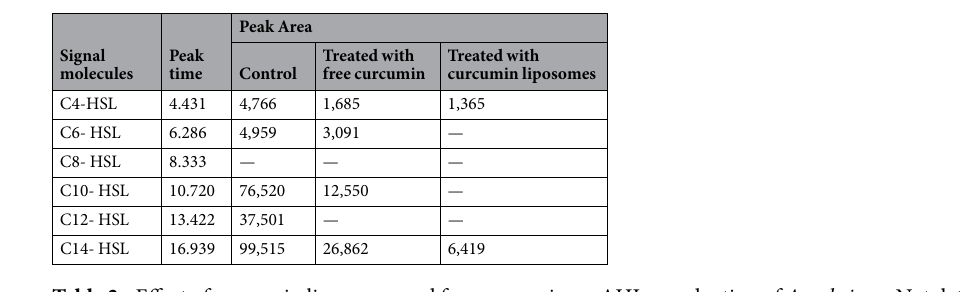
Table 2. Effect of curcumin liposomes and free curcumin on AHLs production of A. sobria . –: Not